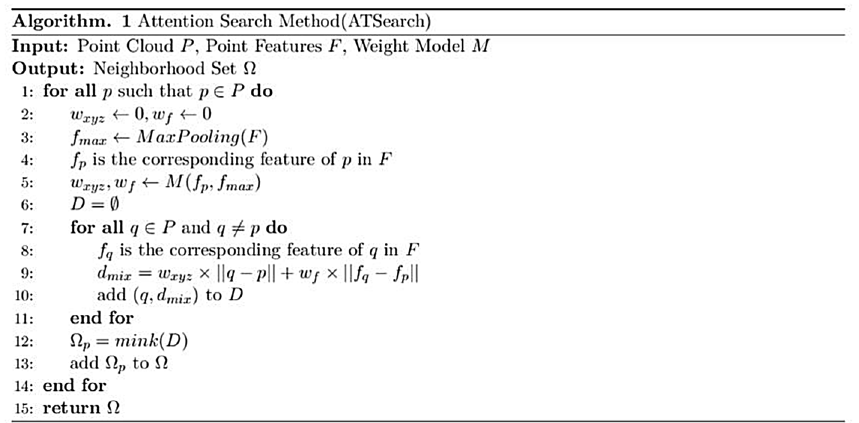
Figure 3. Pseudo code for